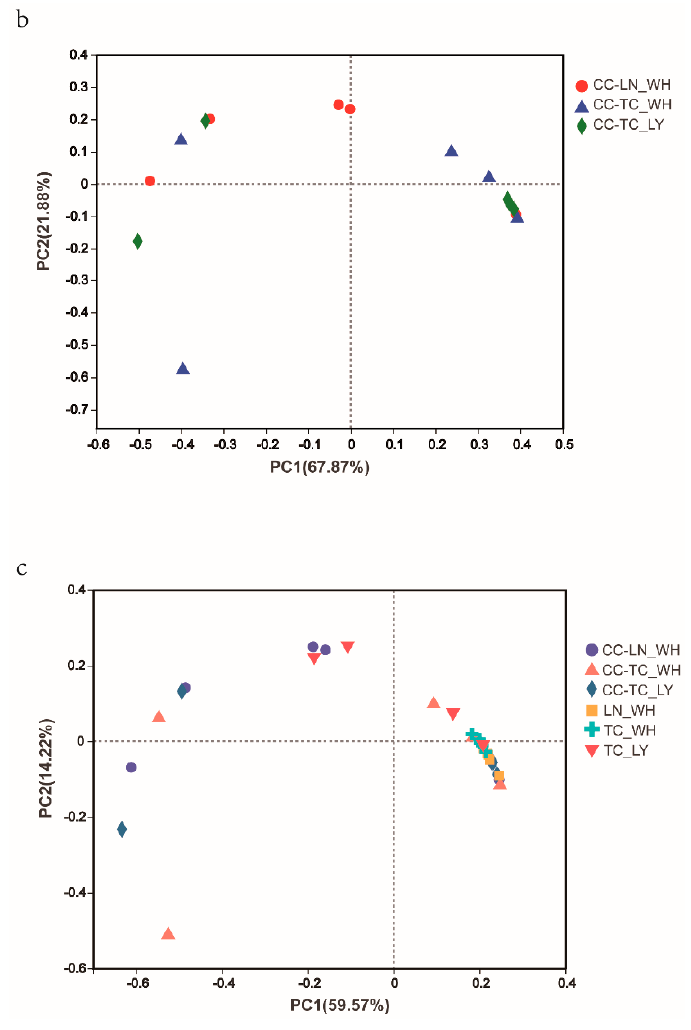
Figure 3. Principal coordinate analysis (PCoA) plots of the bacterial community for ants ( a ) and spiders ( b ) and together ( c ) based on Bray − Curtis distance matrix (PERMANOVA p < 0.05). Each symbol represents one sample. TC_LY, T. caespitum Luoyang; TC_WH, T. caespitum Wuhan; LN_WH, L. niger Wuhan; CC − , spiders fed different diets.